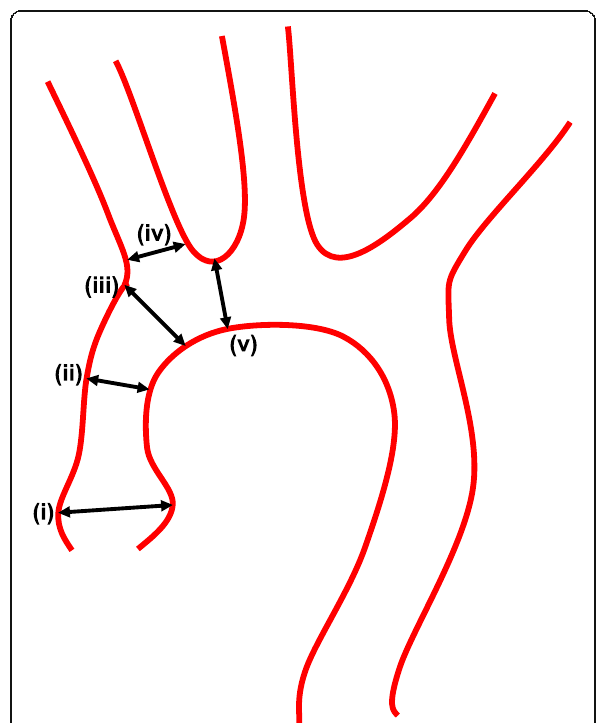
Fig. 1 Scheme of aortic diameters measured in MR images. ( i ) The aortic root, ( ii ) the ascending aorta, ( iii ) the aorta at the level of the brachiocephalic trunk, ( iv ) the brachiocephalic trunk, and ( v ) the aortic